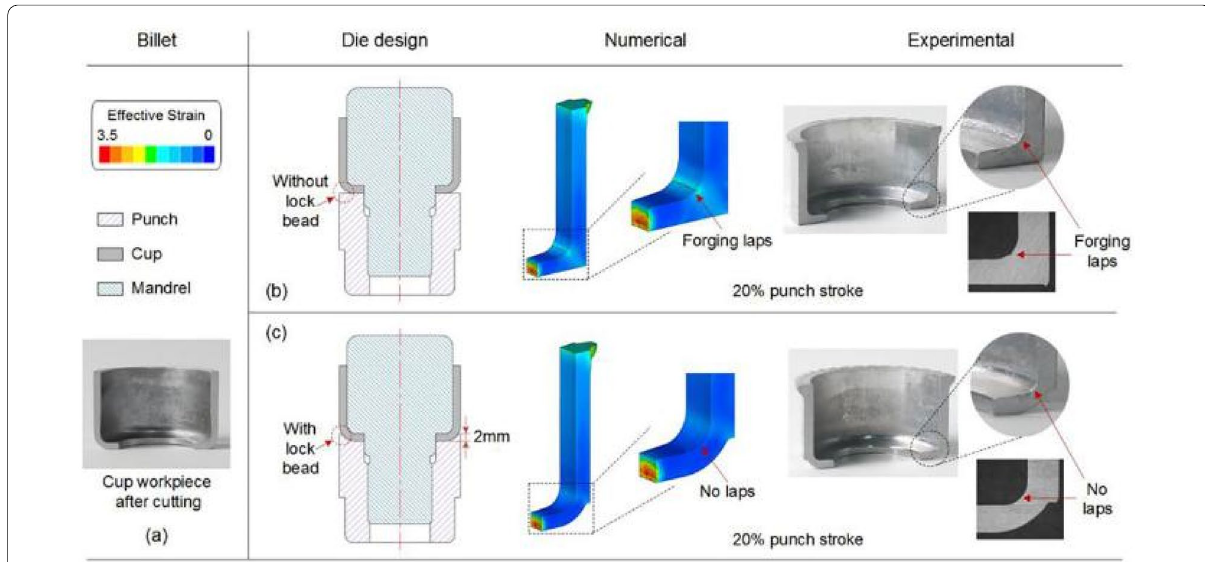
Figure 10 Comparison of forming results: ( a ) cup workpiece after cutting; ( b ) forming results without lock bead on punch; ( c ) forming results with lock bead on